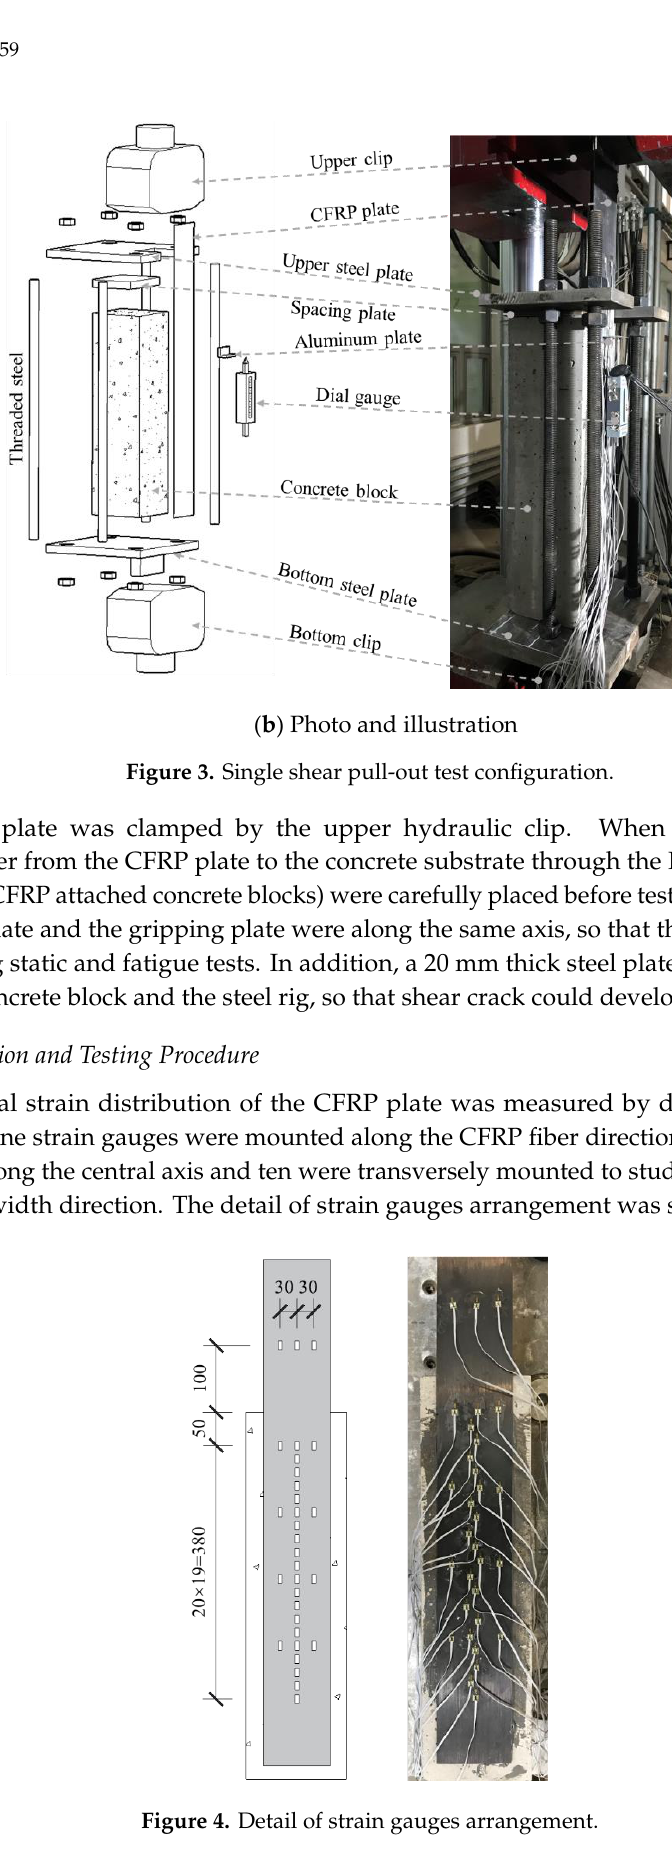
Figure 4. Detail of strain gauges arrangement.